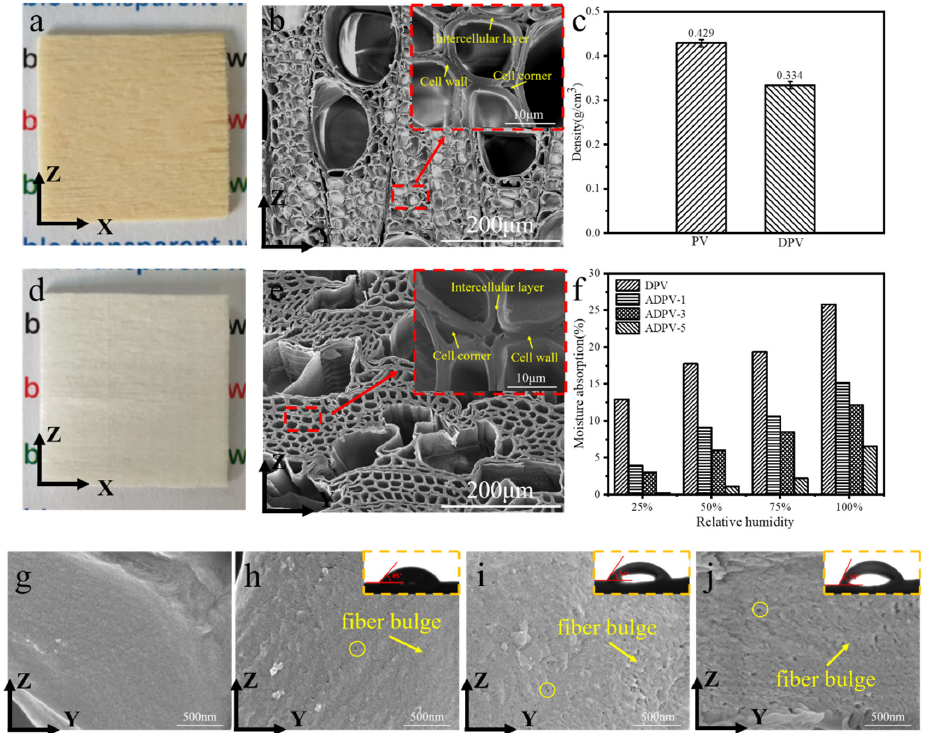
Figure 2. Microstructure and moisture absorption of all specimens for ( a , d ) the material objects of PV and DPV, respectively; ( b , e ) the microstructure of PV and DPV, respectively; ( c ) the density of PV and DPV; ( f ) moisture absorption of DPV and ADPV-1, -3, and -5; ( g – j ) the microstructure of DPV and ADPV-1, -3, and -5, respectively (X-longitudinal direction; Y-tangential direction; Z-radial direction of the wood).